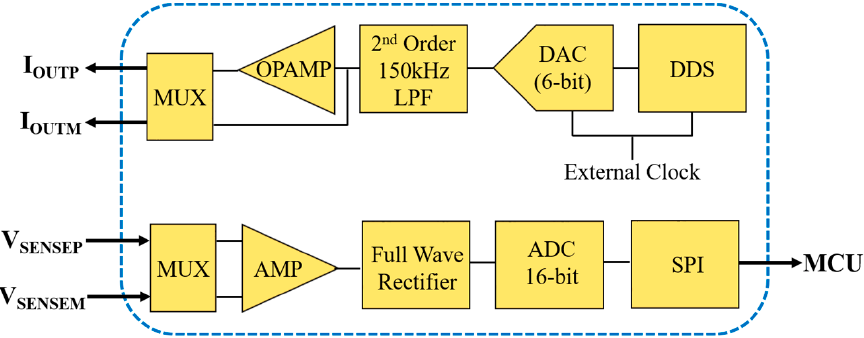
Figure 11. Body composition measurement block for bioimpedance measurement (full wave rectification method).